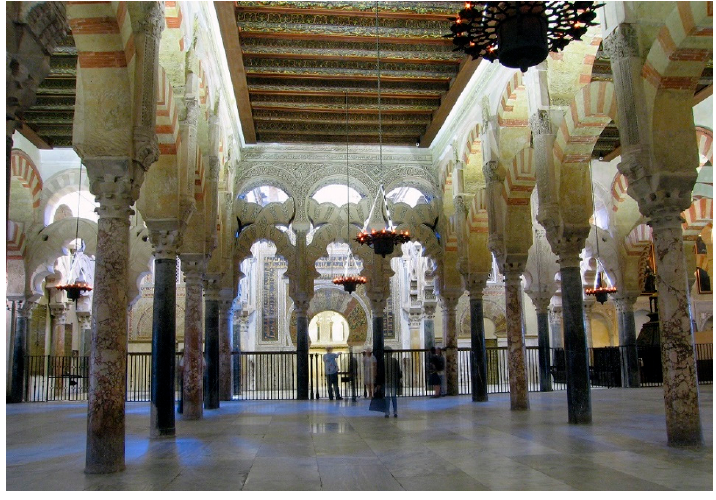
Figure 11. Great Mosque of Cordoba. Panoramic view of the axial nave to the qibla wall. © Photo took by author.